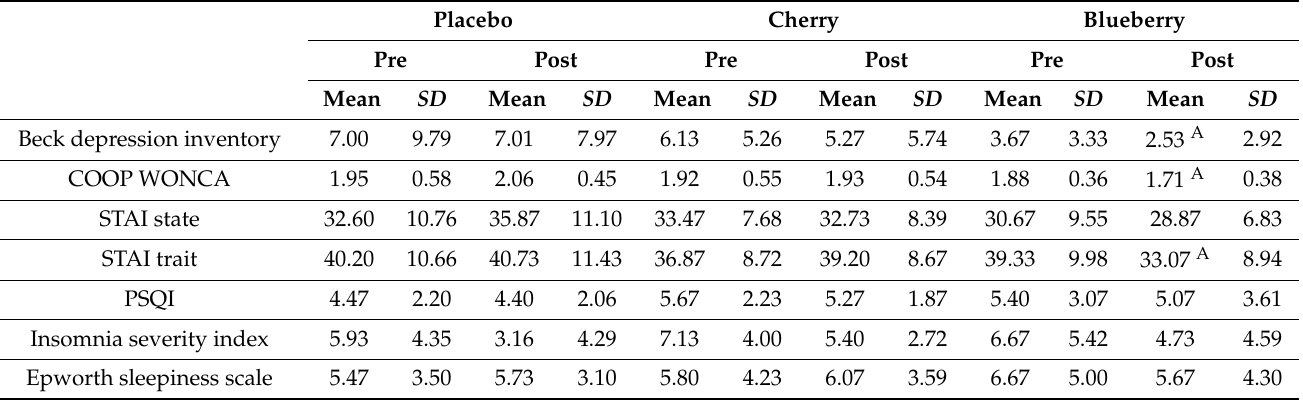
Table 7. Questionnaire measurements as a function of each trial